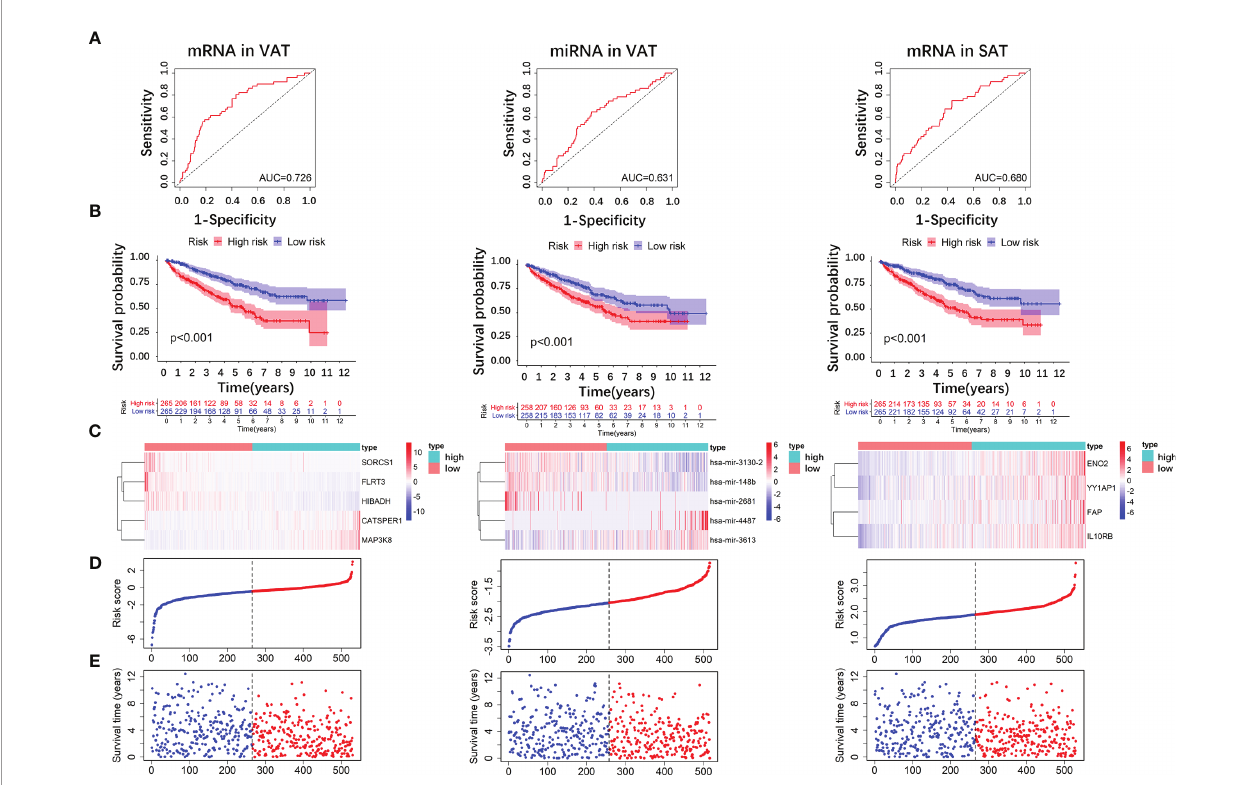
FIGURE 7 | Risk score analyses of DE RNAs of obesity-related ccRCC in the prognosis of ccRCC. 5 DE mRNAs (SORCS1, FLRT3, HIBADH, CATSPER1, and MAP3K8), 5 DE miRNAs (hsa-miR-3130-2, hsa-miR-148b, hsa-miR-2681, hsa-miR-4487, and hsa-miR-3613) of obesity-related ccRCC in VAT, and 4 mRNAs (ENO2, YY1AP1, FAP, IL10RB) in SAT were used to calculate risk scores. AUC of risk score of mRNAs in VAT was larger than those of miRNAs in VAT, and mRNAs in SAT (A) . Overall survival time of patients in the low ‐ risk group was signi fi cantly longer than in the high ‐ risk group regardless of risk score models (B) . Distributions of RNA expressions, risk scores, and survival statuses for each patient were also shown (C – E)